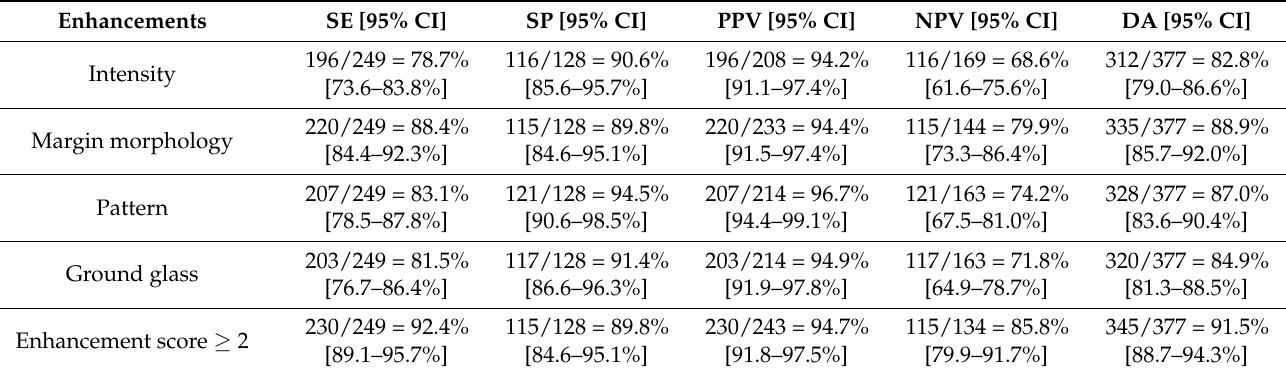
Table 3. Diagnostic performance of CESM enhancements and the corresponding histological result (benign vs. any malignancy) as the gold